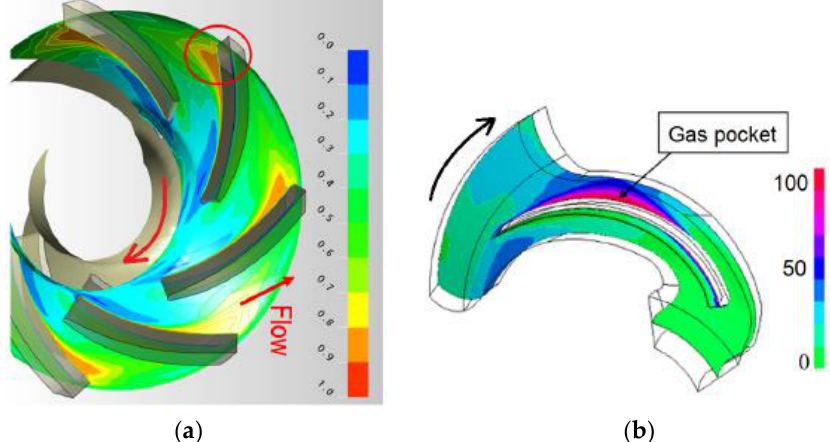
Figure 12. Computational fluid dynamics (CFD) results obtained by Ossia [93]. ( a ) Radial flow pump with GVF = 10% and bubble diameter d = 0.5 mm, and Caridad [94] ( b ) mixed-flow pump with GVF = 30% and d = multiple size bubble.